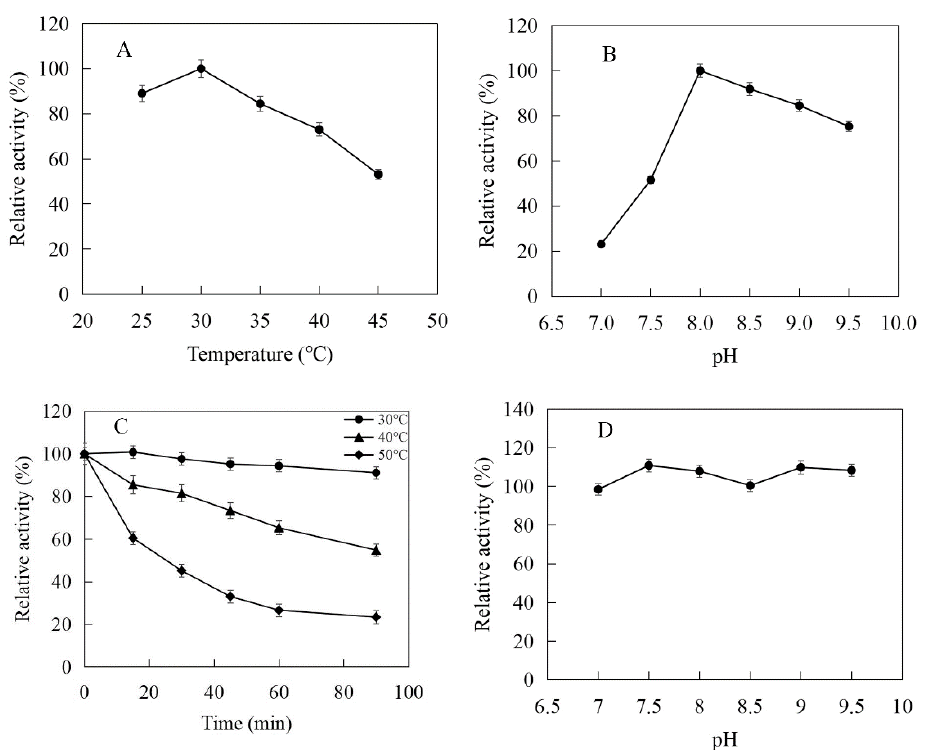
Figure 9. Effects of pH and temperature on the activity and stability of MthIPK: ( A ) Effect of temperature on the activity of MthIPK. ( B ) Effect of pH on the activity of MthIPK. ( C ) Thermostability of MthIPK. ( D ) pH stability of MthIPK.